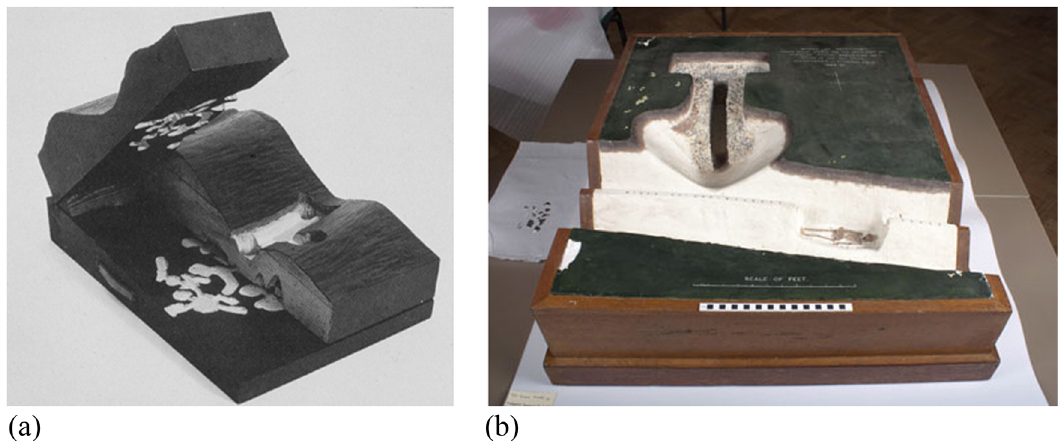
Figure 7: ( a ) The Cissbury model, from the Farnham Collection, now in The Salisbury Museum ( with permission of The Salisbury Museum ) , ( b ) the model of Woodyates [ CC BY - SA 4.0 license, downloaded from https://www.dayofarchaeology.com/the - pitt - rivers - archaeological - models/ ]